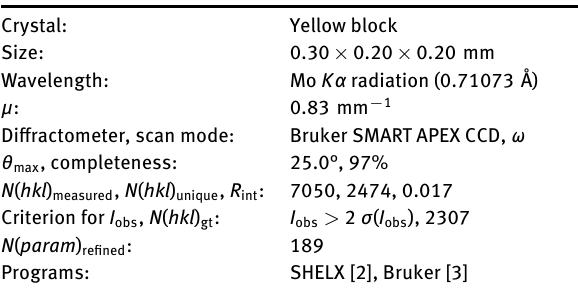
Table 1: Data collection and handling.